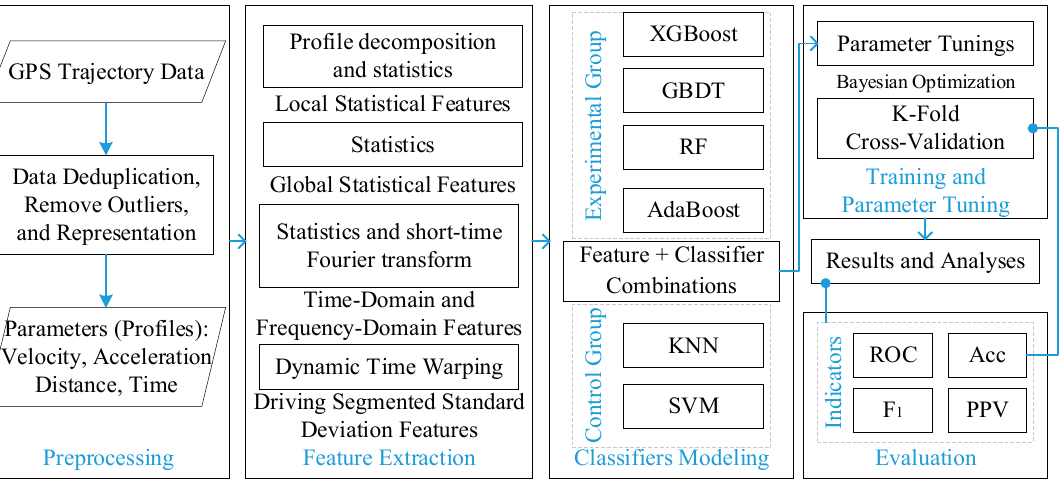
Figure 1. Main Modules of the Methodologies for Identifying Modes of Driving Railway Trains (MDRT).